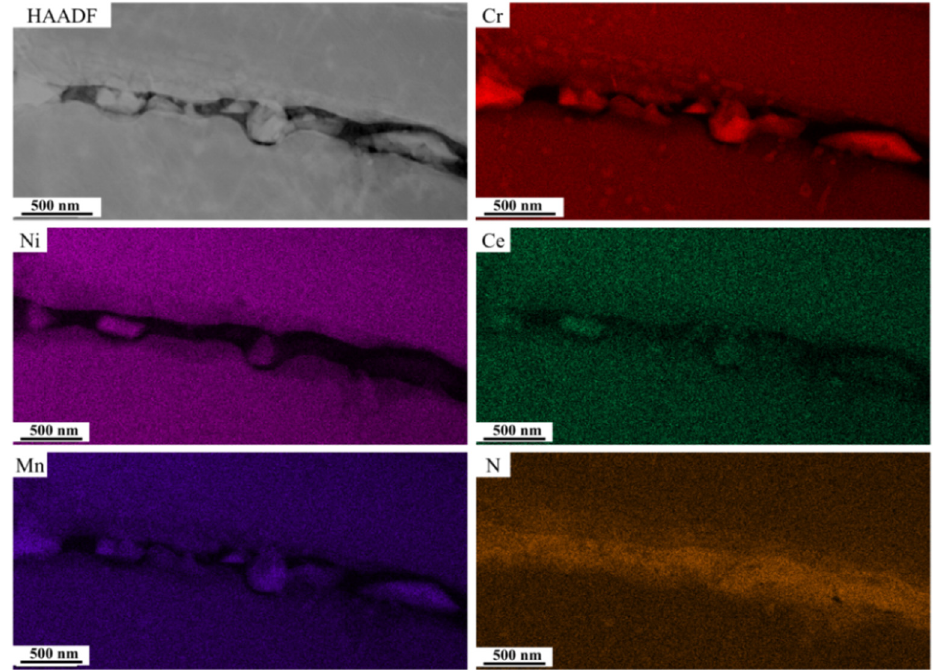
Figure 11. EDS of grain boundary of the creep sample in HAZ.